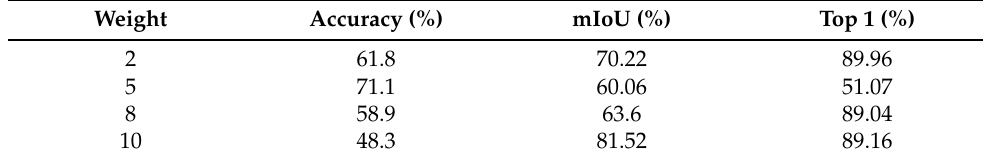
Table 9. Comparison of weights of object detection loss.